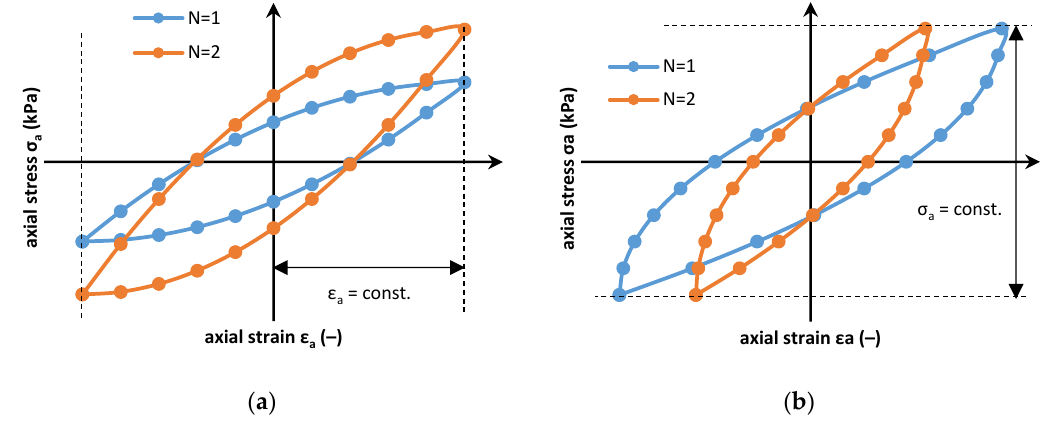
Figure 2. Soil respond to repeating loading in strain-controlled test ( a ) and stress-controlled test ( b ).